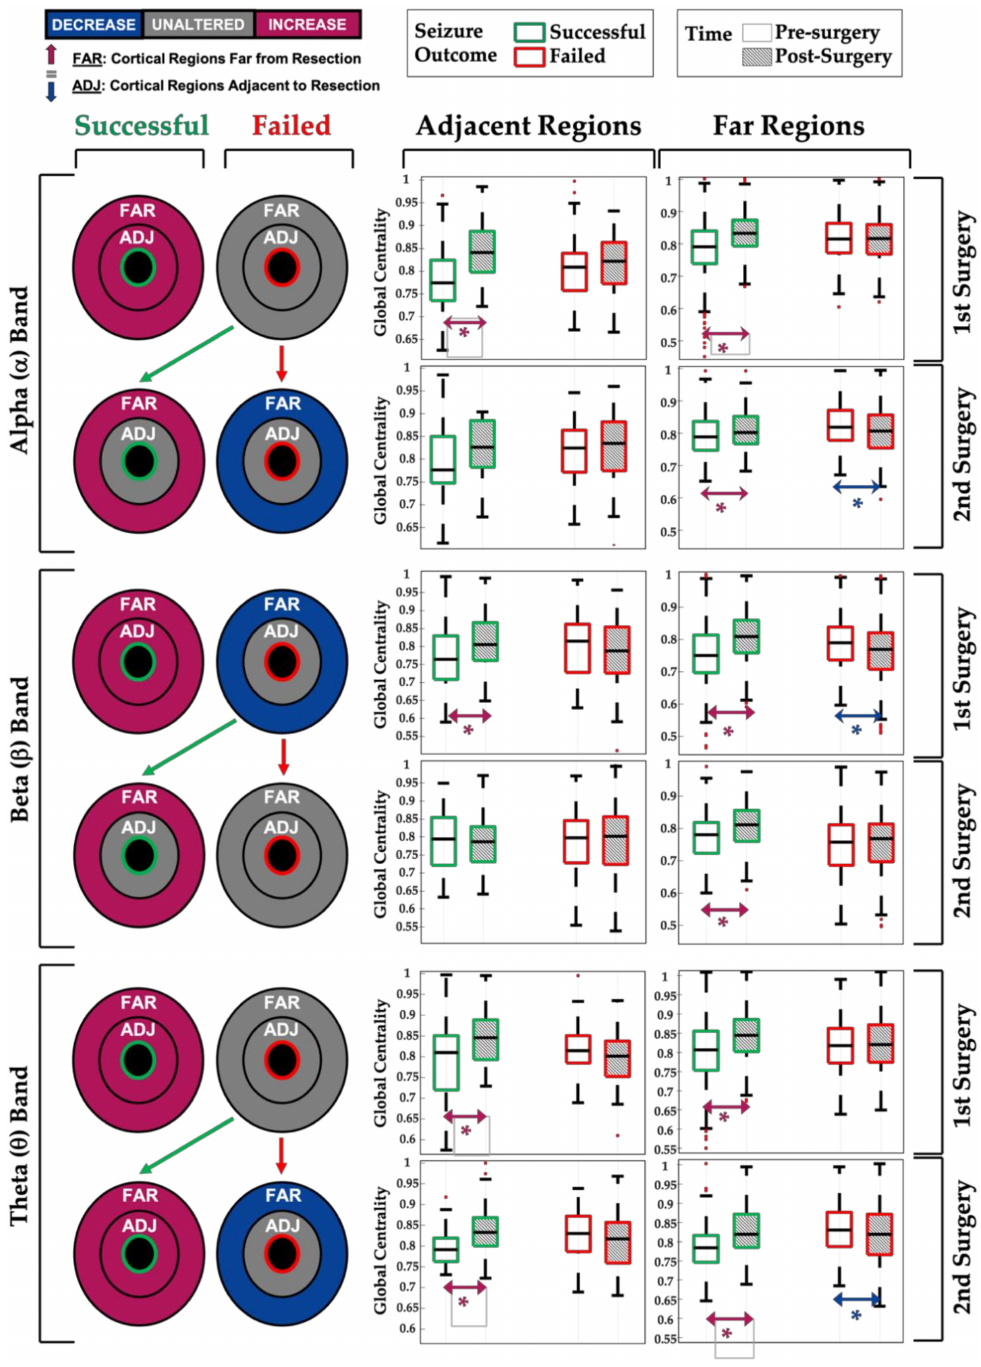
Figure 5. Global centrality in alpha, beta, and theta bands. For each frequency band, four circular diagrams and the corresponding boxplots are shown. For each surgery, we compared global